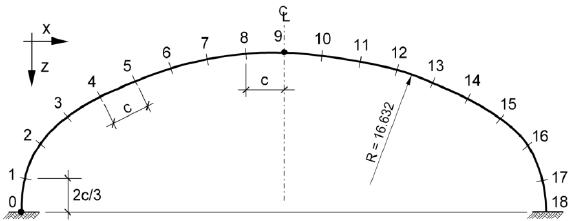
Figure 5: Arrangement of measuring points in perimeter zone of shell in Ostróda.